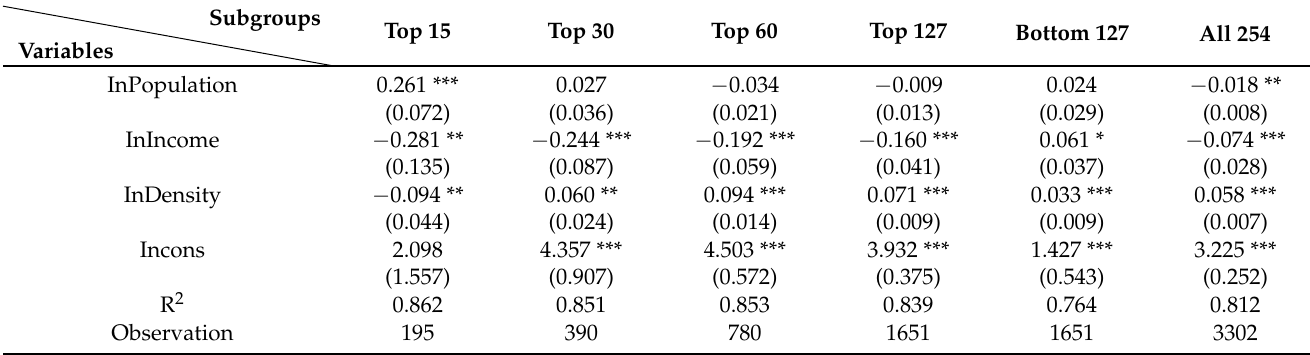
Table 6. Multivariate panel analysis of PM 2.5 concentrations for six population subgroups (2001–2013).